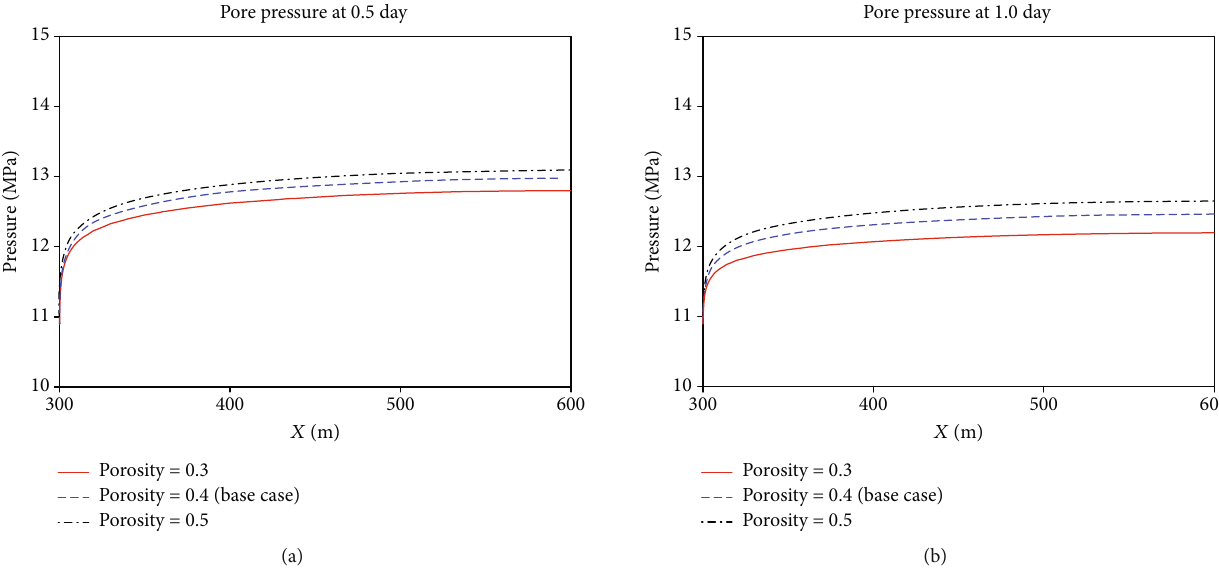
Figure 12: 1D pressure distribution from the wellbore to the domain boundary along Y = 300 m after (a) 0.5 day and (b) 1 day of shallow water fl ow for porosity sensitivity.